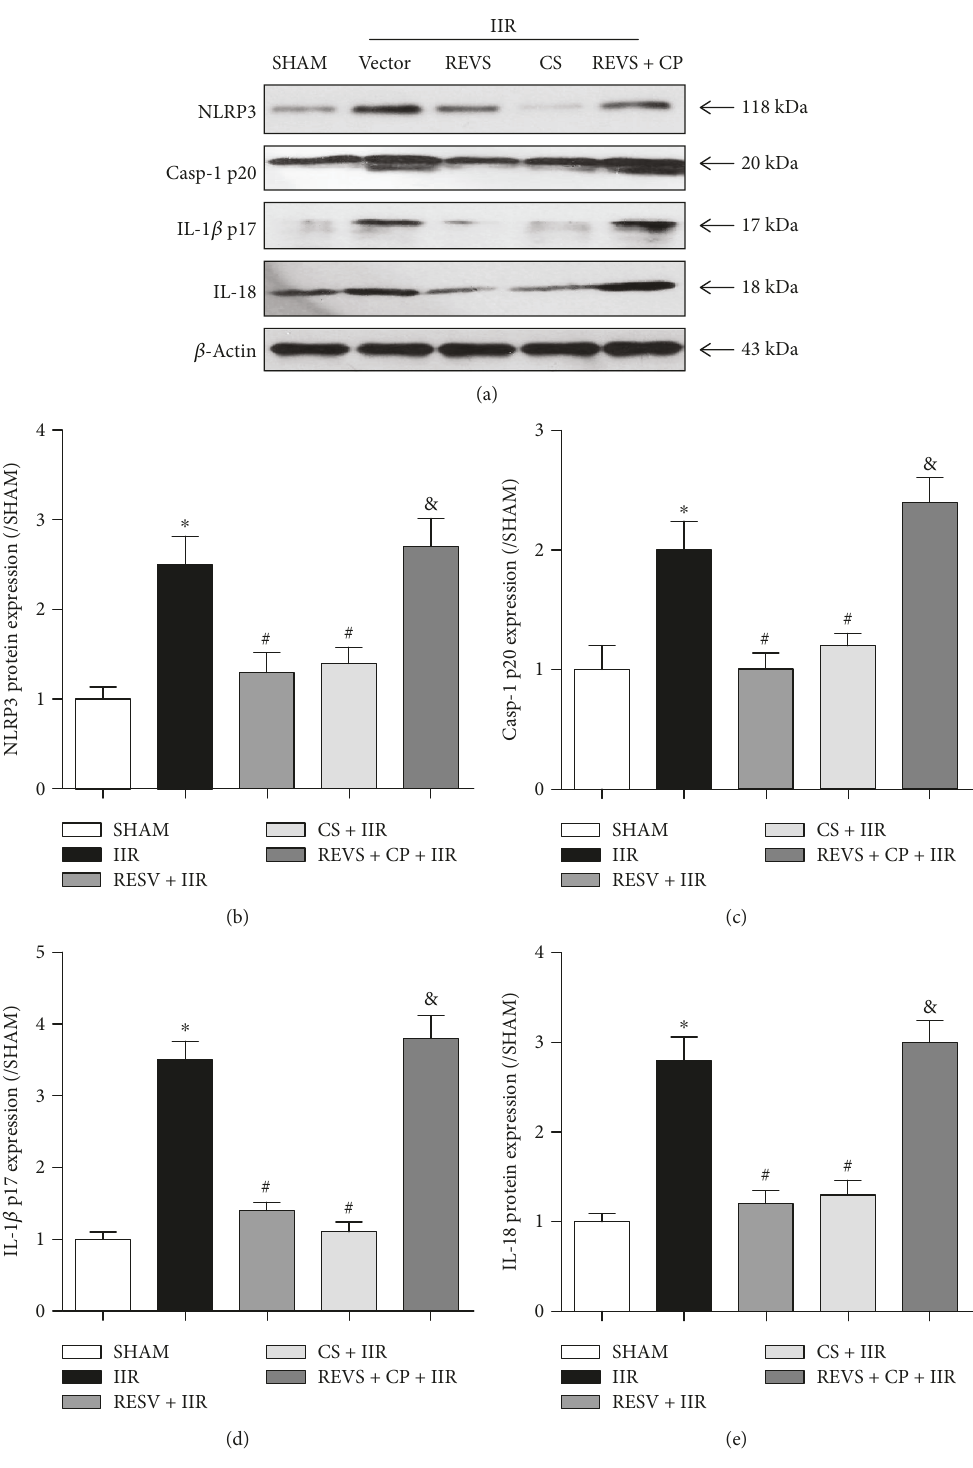
Figure 3: Resveratrol pretreatment inhibited NLRP3 in fl ammasome activation by stabilizing mast cells. (a) Representative western blotting bands of NLRP3, caspase-1 p20, IL-1 β p17, and IL-18 for each group. (b) NLRP3 protein expression level. (c) Caspase-1 p20 protein expression level. (d) IL-1 β p17 protein expression level. (e) IL-18 protein expression level. IIR: intestinal ischemia-reperfusion; RESV: resveratrol; CP: compound 48/80; CS: cromolyn sodium. Data are expressed as the means ± SEM, n = 8 /group. ∗ P < 0 05 vs. sham group, # P < 0 05 vs. IIR group, & P < 0 05 vs. RESV+IIR